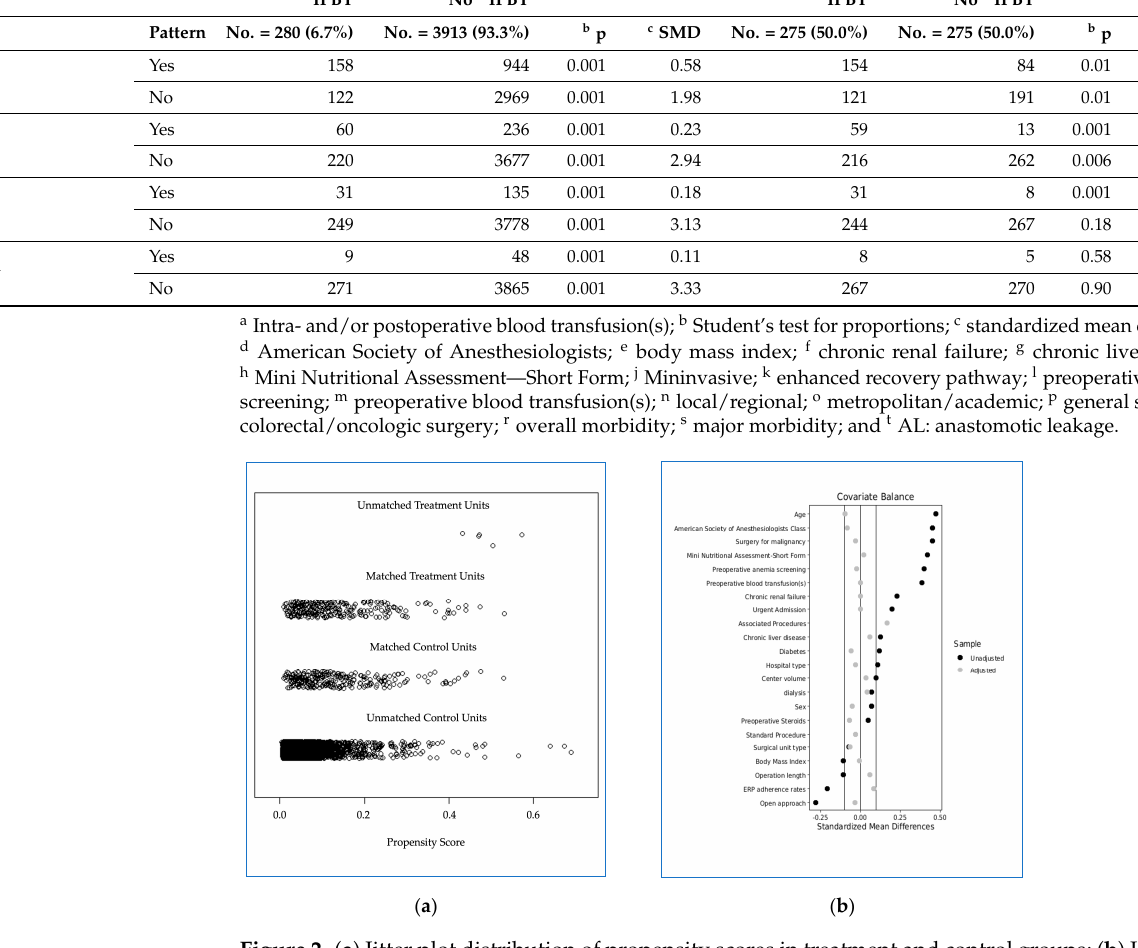
Figure 2. ( a ) Jitter plot distribution of propensity scores in treatment and control groups; ( b ) Love plot of covariates’ standardized mean differences between treatment and control groups before and after matching; the vertical lines represent the interval of ±0.1 and within which balance is consid- ered to be acceptable. After adjusted logistic regression, group A vs. group B (Table 4) showed a signifi- cantly higher risk of OM (154 (56.0%) vs. 84 (30.5%) events; OR 3.07; 95%CI 2.13–4.43; p = 0.001), MM (59 (21.4%) vs. 13 (4.7%) events; OR 6.06; 95%CI 3.17–11.6; p = 0.001), and AL (31 (11.3%) vs. 8 (2.9%) events; OR 4.72; 95%CI 2.09–10.66; p = 0.0002). No difference was recorded between the two groups (8 (2.9%) vs. 5 (1.8%) events; OR 1.57; 95%CI 0.42–5.79; p = 0.50) concerning the risk of mortality. Table 4. Adjusted multiple regression analysis for endpoints.